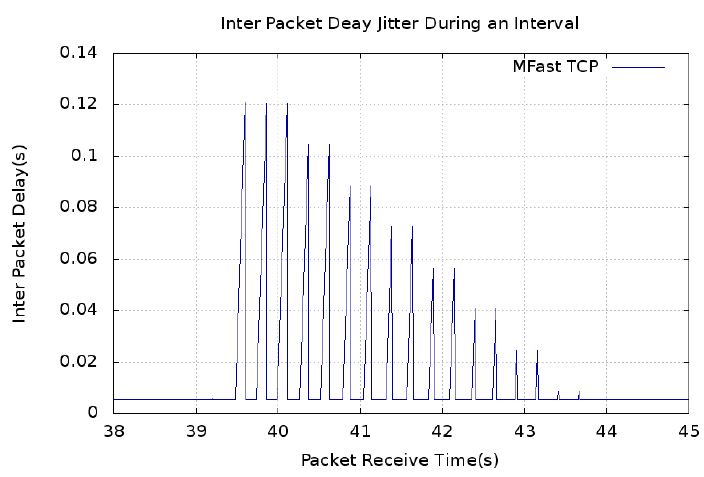
Figure 4. Inter-packet delay jitter during and after fast-retransmit and -recovery phase of MFast TCP.